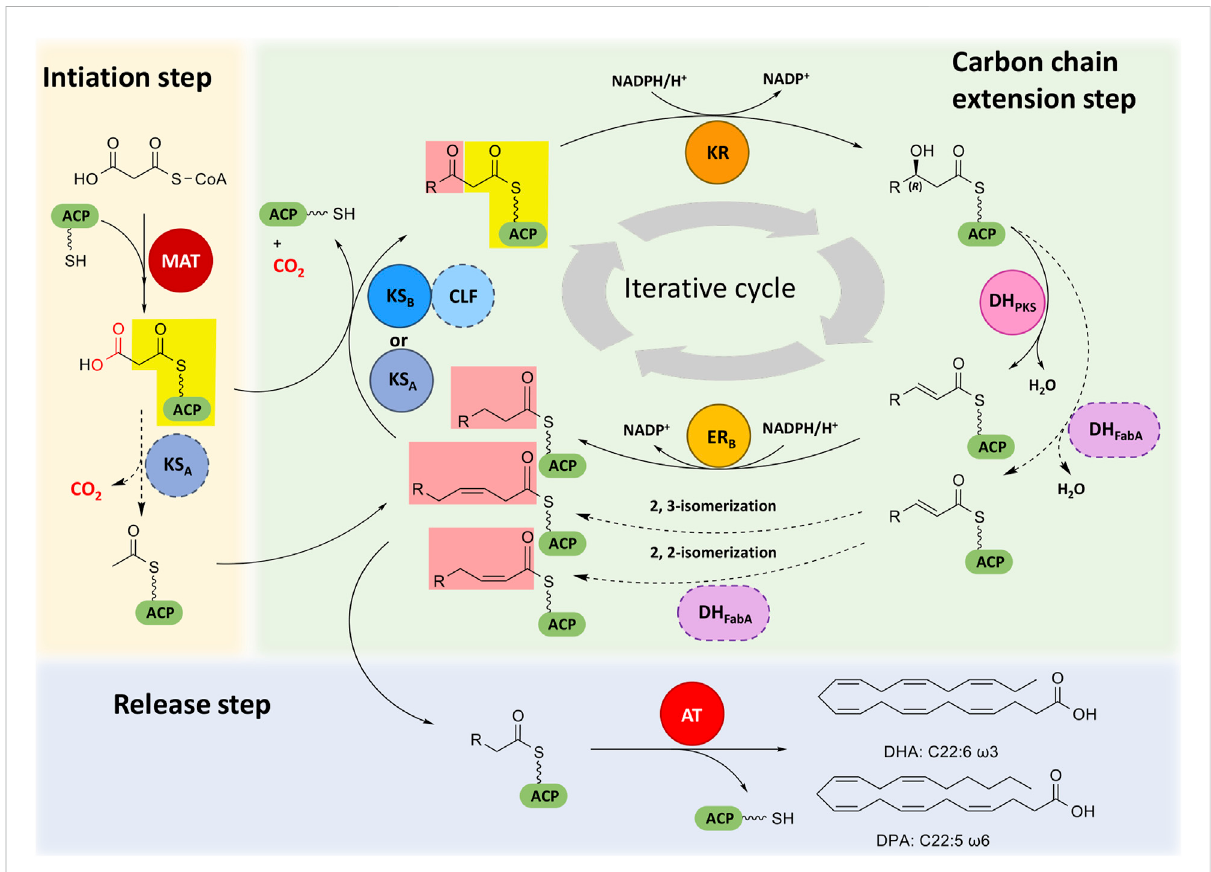
FIGURE 2 Proposed PUFA biosynthetic machinery in eukaryotic PUFA synthases. Different domains are indicated by colors. ACP, acyl carrier protein domain; MAT, malonyl-CoA: ACP transacylase domain; KS, ketoacyl-ACP synthase domain; CLF, chain length factor domain; KR, ketoacyl-ACP reductase domain; DH PKS , PKS-like dehydratase domain; DH FabA , FabA-like dehydratase domain; ER, enoyl-ACP reductase domain; AT, acyltransferase domain. Dotted arrows indicate possible reactions, and domains with dashed outlines indicate their possible involvement